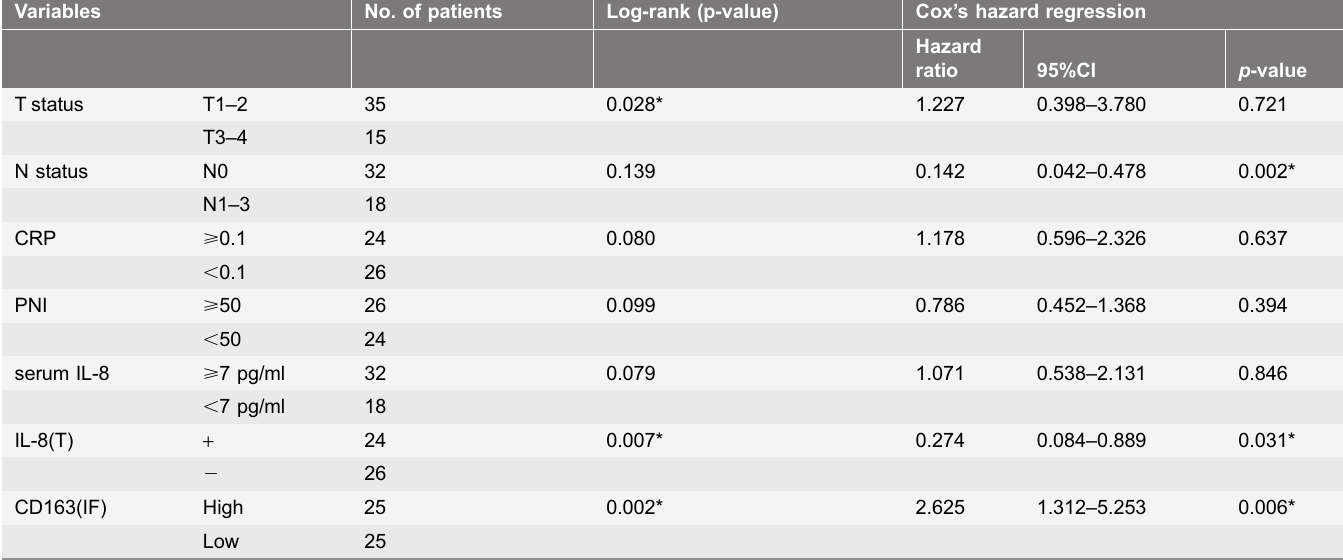
Table 4. Univariate and multivariate analyses of factors affecting DFS after surgical resection of OSCC. Variables No. of patients Log-rank (p-value) Cox’s hazard regression